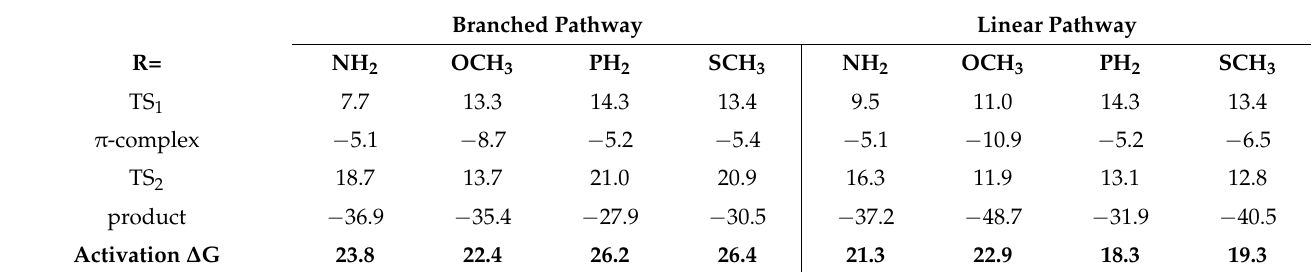
Table 4. Relative Gibbs free energies (kcal · mol − 1 ) of π -complexes, transition states, and products of the addition of Cu(CH 3 ) 2 · Li to alkynes of the form R-C ≡ C-CH 3 . For each alkyne, all energies are shown relative to the energy of the infinitely separated reactants. Single-point energies were computed at the PBEPW91/6-311G(2d,p)//6-31G(d), including solvation effects in THF and zero- point and vibrational effects at 223 K. Branched Pathway Linear